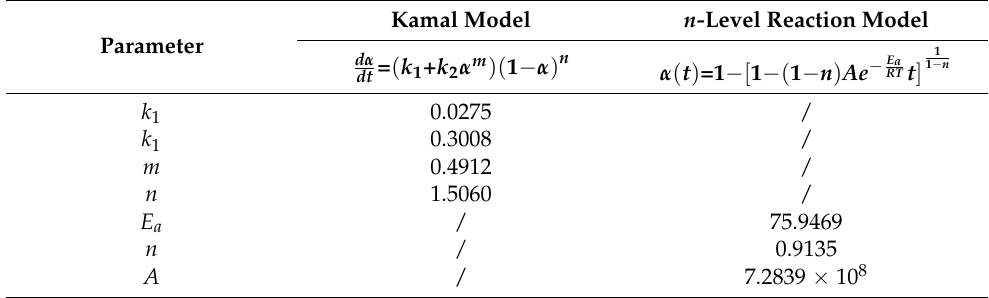
Table 3. Model-fitting curing kinetics of DEBGA/MHHPA system with 0.2 wt% DMP-30